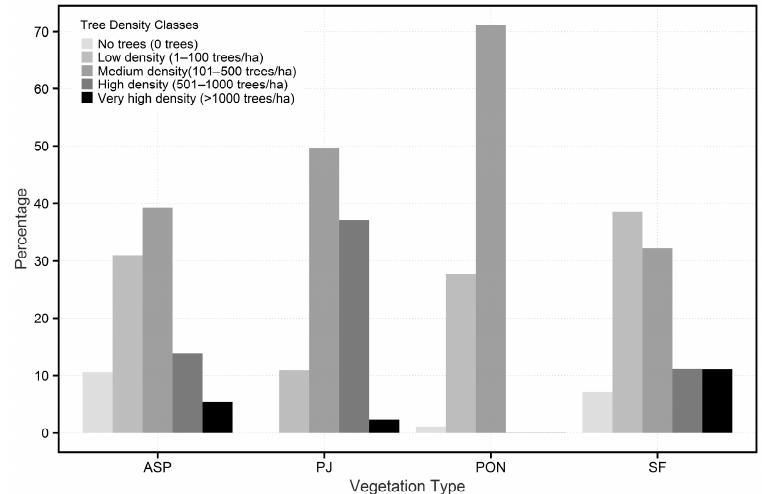
Figure 3. Percent of predicted density classes by vegetation type (ASP, Aspen; PJ, Piñon-Juniper; PON, Ponderosa; and SF, Spruce-Fir) in the Southwest Jemez Mountains, New Mexico, USA.